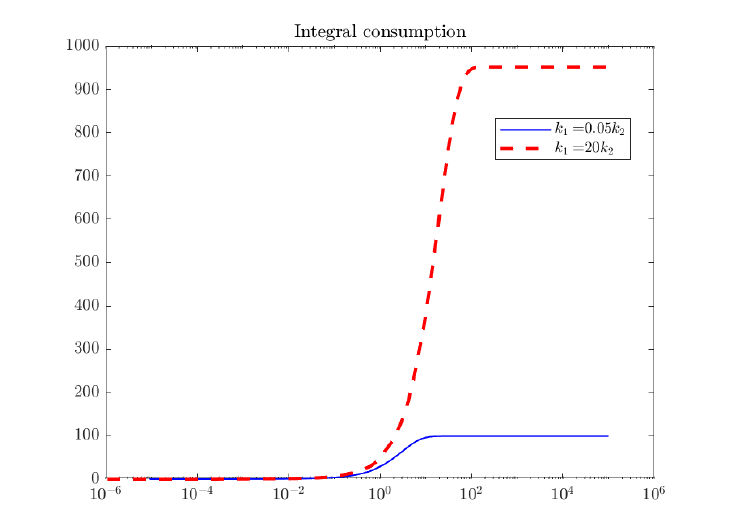
Figure 5. Integral consumption for different k 1